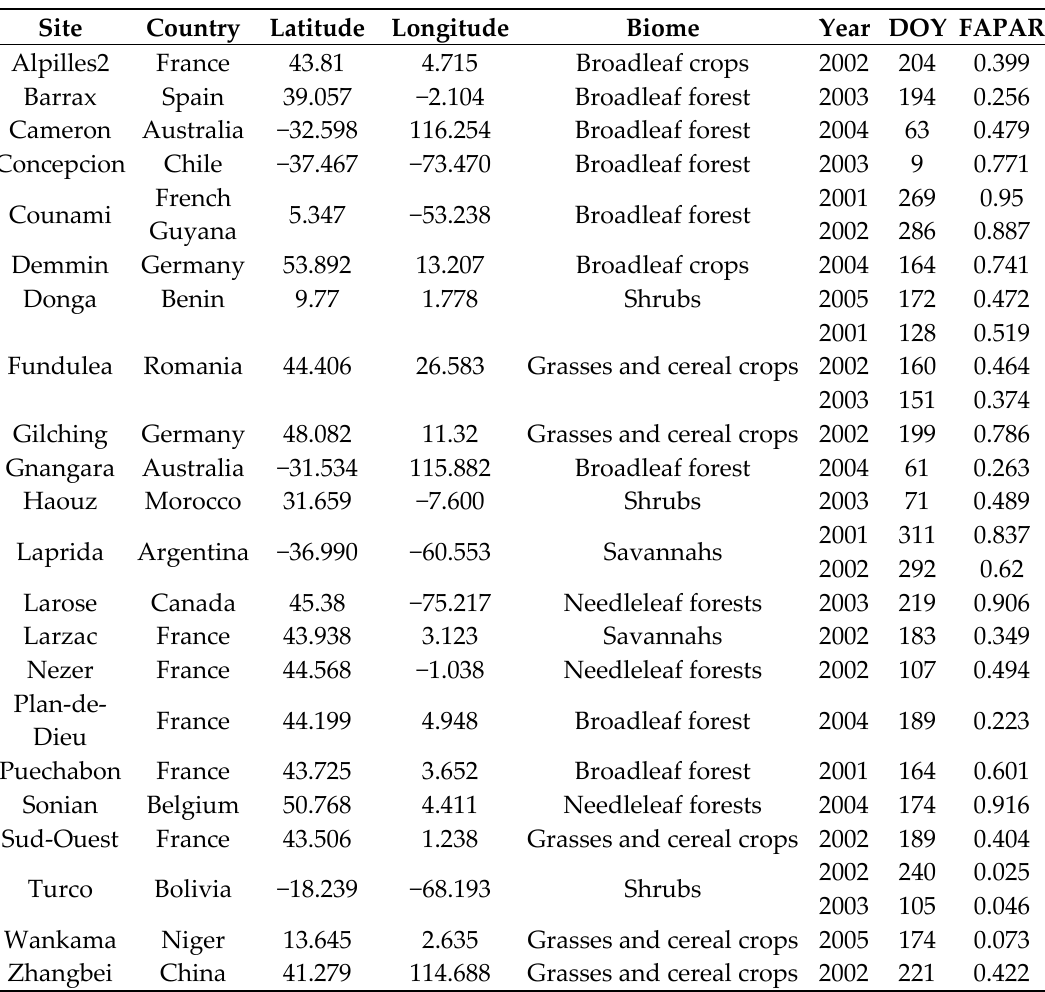
Table 2. The VALERI sites and their FAPAR (fraction of absorbed photosynthetically active radiation by vegetation) records. DOY is day of